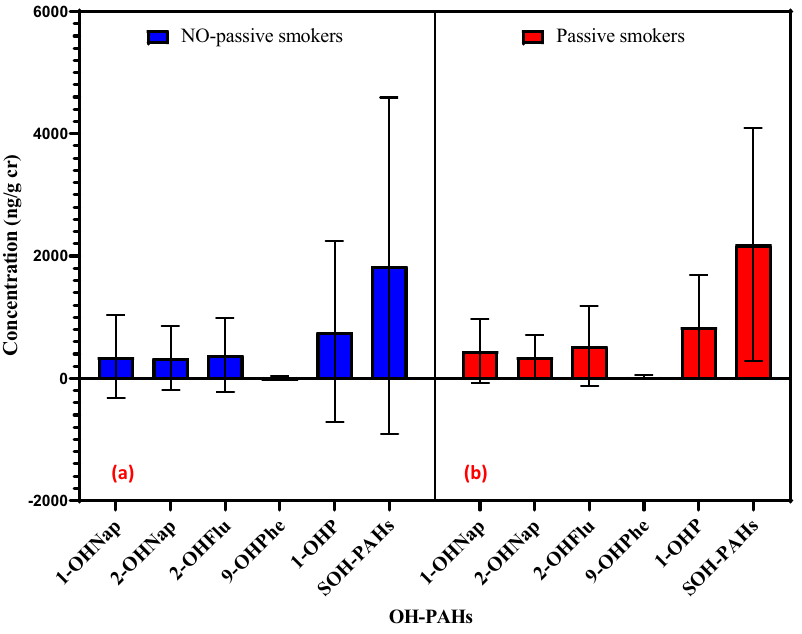
Figure 3. A comparison of mean PAH metabolites concentration (ng/g cr) in urine samples of ( a ) non-passive and ( b ) passive smokers.